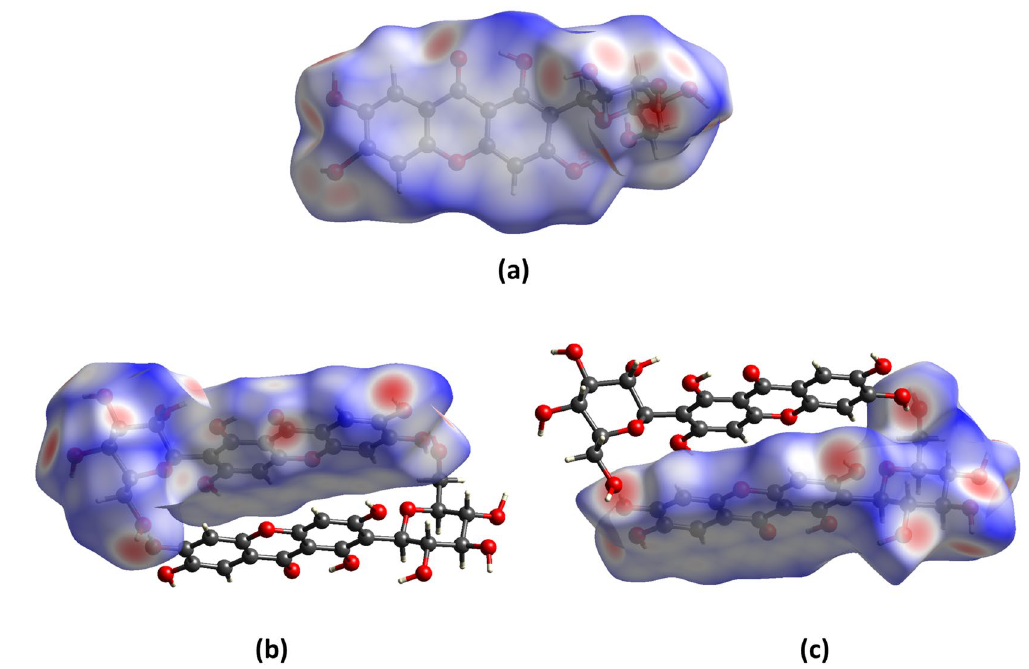
Fig. 6 Hirshfeld surface mapped with d norm for two polymorphs of mangiferin, where a was for mangiferin molecule in form I, b , c were for two molecules in form